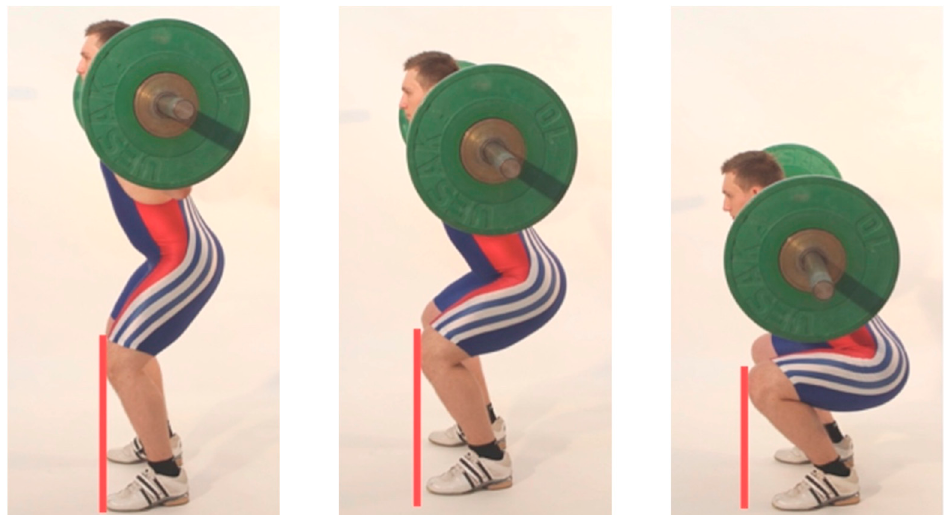
Figure 1. “Quarter”, “half”, and parallel high-bar back squat (QHBBS, HHBBS, and PHBBS). AKD is enhanced by lower squatting depth (see red lines). Modified with permission from [38]. Subjects performing a QHBBS were able to move an average load 4.02 ( ± 1.59)